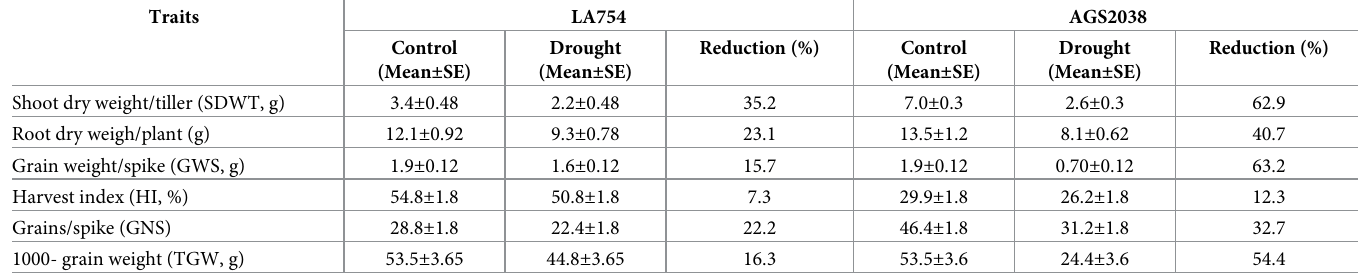
Harvest index (HI, %) Grains/spike